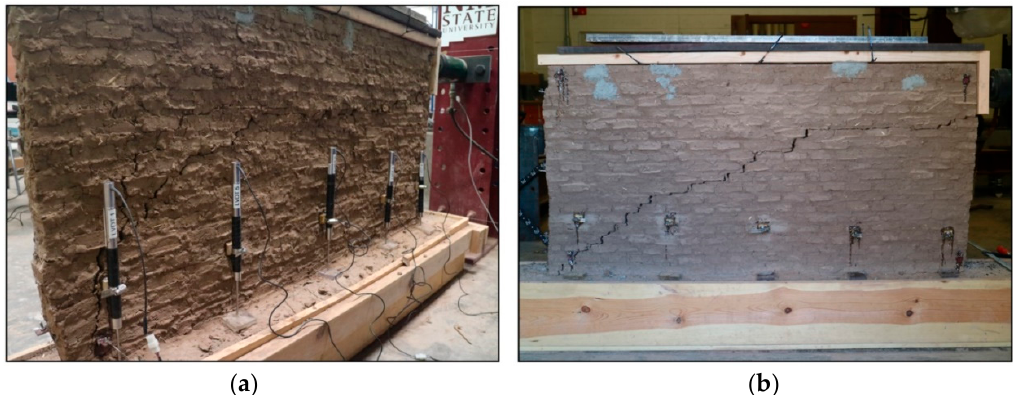
Figure 6. Wall 1: ( a ) During loading; ( b ) after failure (after test completion).